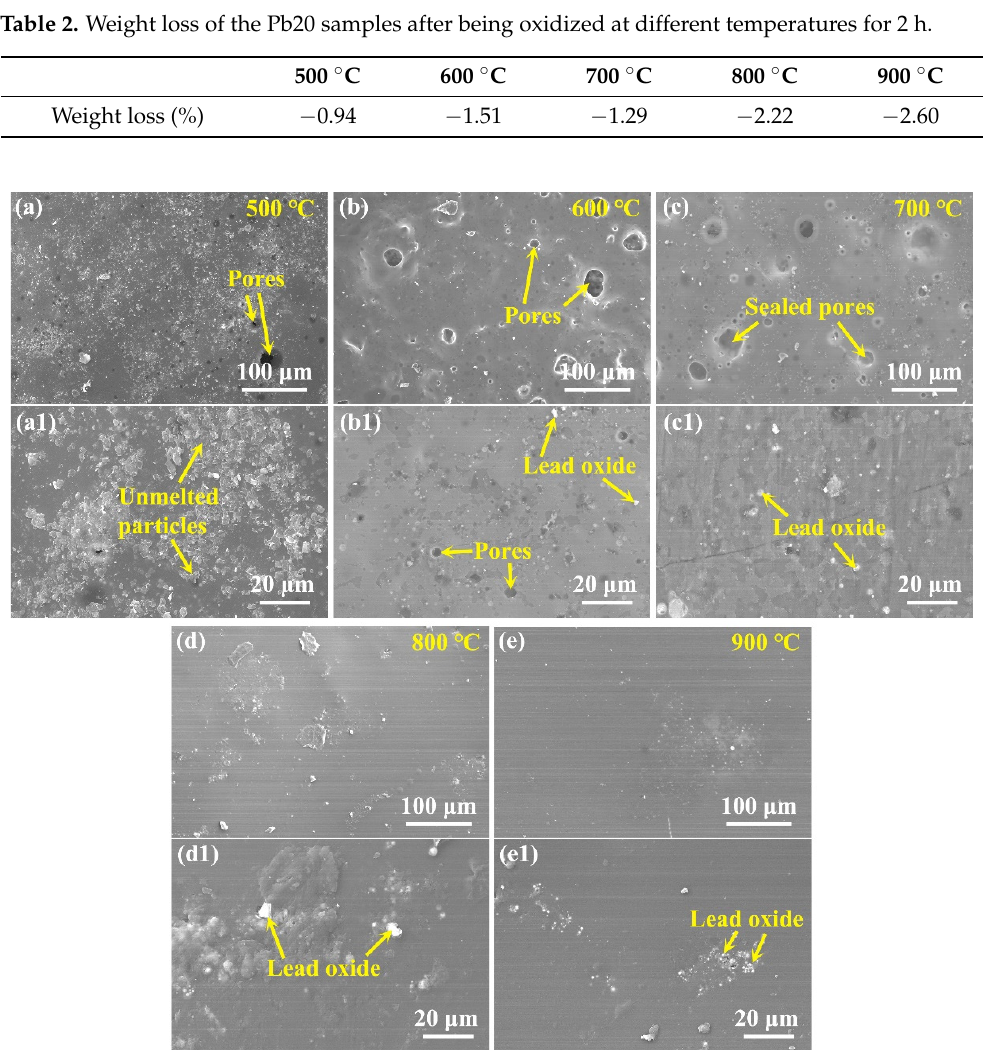
Figure 10. Surface images of the PSN/lead–borosilicate glass–B 4 C coated C/C after oxidation at dif- ferent temperatures for 2 h: ( a , a1 ) 500 °C; ( b , b1 ) 600 °C; ( c , c1 ) 700 °C; ( d , d1 ) 800 °C; and ( e , e1 ) 900 temperatures for 2 h: ( a , a1 ) 500 ◦ C; ( b , b1 ) 600 ◦ C; ( c , c1 ) 700 ◦ C; ( d , d1 ) 800 ◦ C; and ( e , e1 ) 900 ◦ °C.